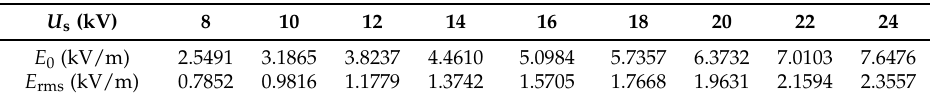
Table 2. Comparison of electric field values at point P before and after placing the measuring sensor (driven by different voltages).